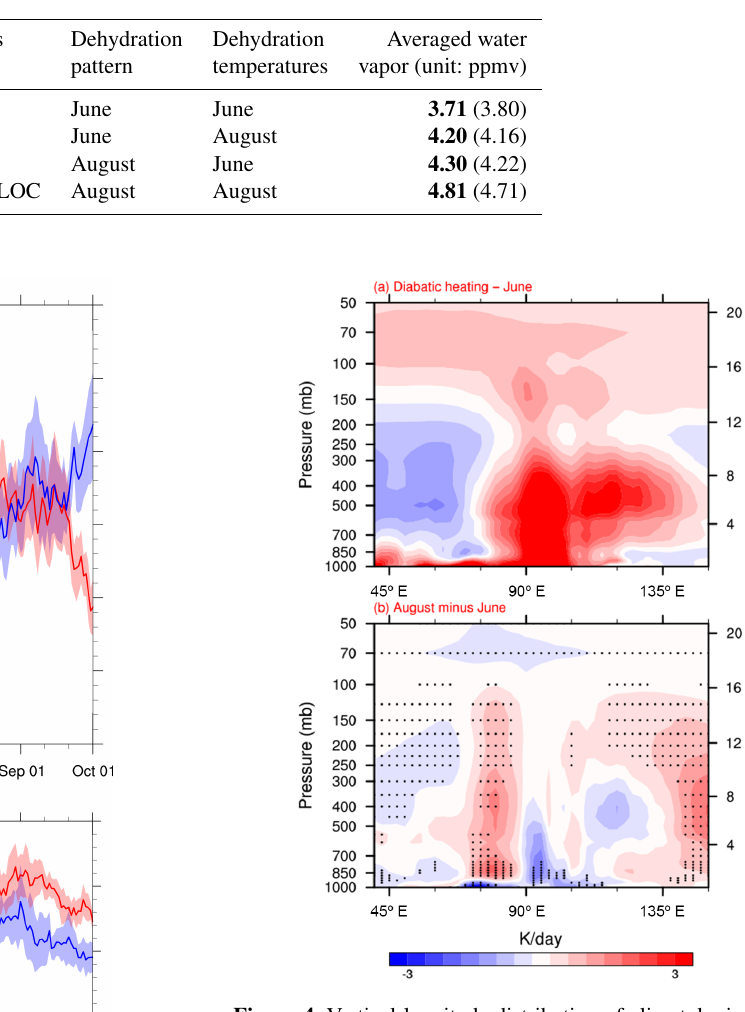
Figure 4. Vertical-longitude distribution of climatological diabatic heating averaged within 15–30 ◦ N in ERA-Interim for (a) June; (b) difference between August and June. The differences that are significant at 95% level based on student t test are